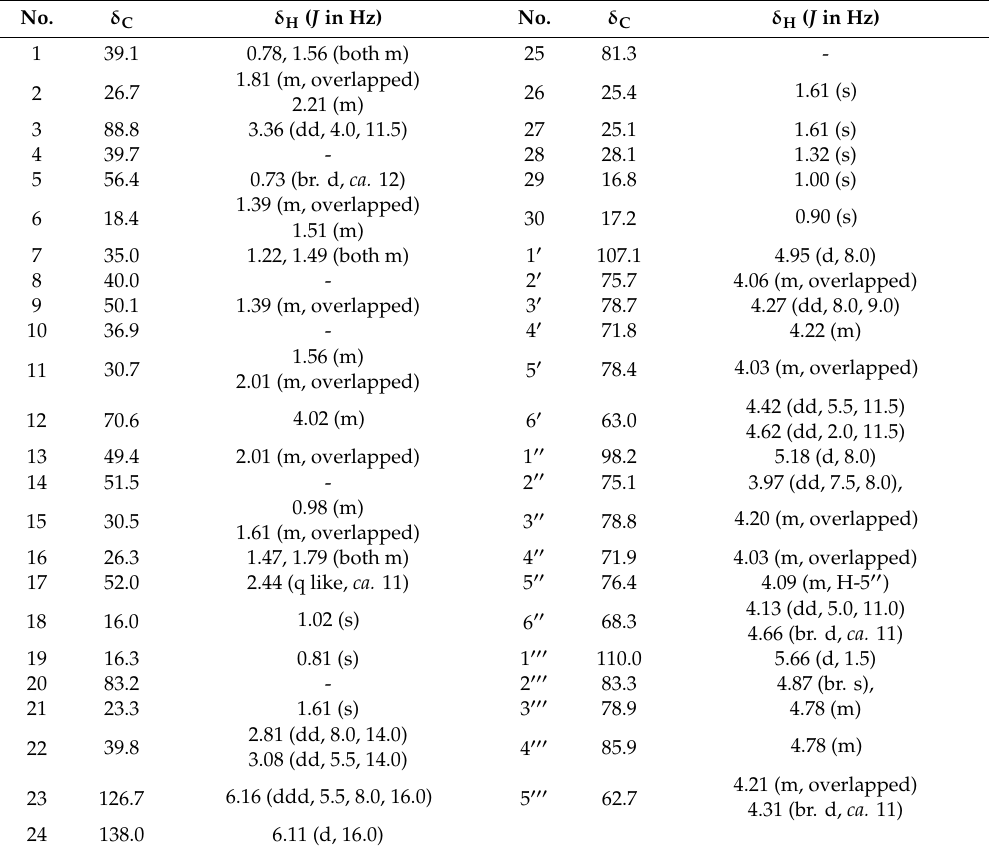
Table 1. The 1 H and 13 C-NMR data for 1 in C 5 D 5